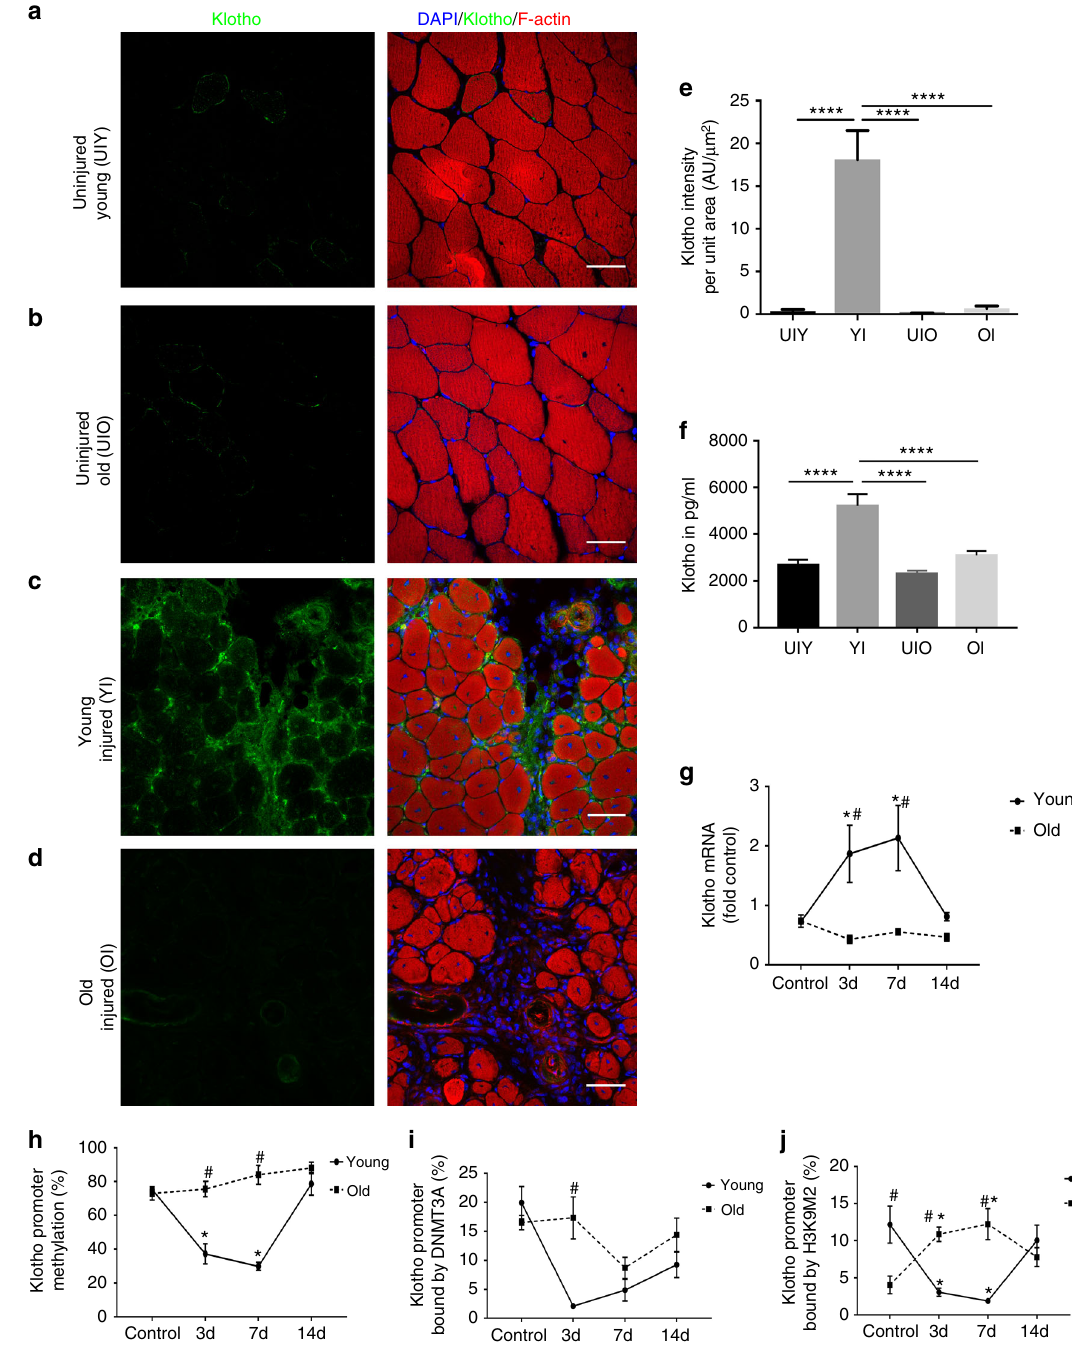
Fig. 1 α -Klotho is increased in young muscle after injury, but the response is lost with increased age. a − d Immuno fl uorescent imaging of α -Klotho and